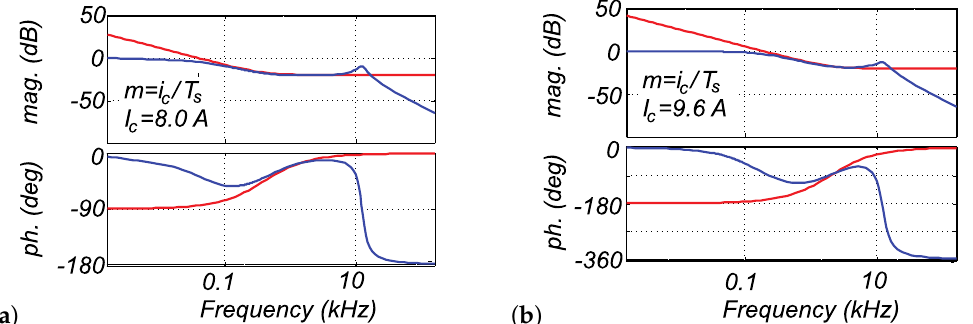
Figure 14. Frequency response, current control with PI compensator, closed loop (blue curve) and C i ( s ) (red curve), for ( a ) buck controller design; ( b ) boost controller